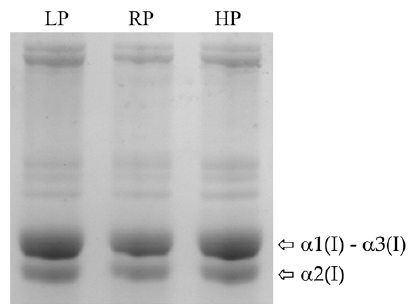
Figure 7. Electrophoretic analysis of collagen type I. Coomassie stained SDS-Urea-PAGE of collagen type I extracted from bone of low P diet (LP) treated zebrafish, controls (RP) and high P diet (HP) treated animals (pool of 2 samples per dietary group). Zebrafish present three collagen type I α chains ( α (I)), named α 1(I), α 3(I) and α 2(I). Collagen α (I) chains show bands with similar electrophoretic migration in all dietary groups.